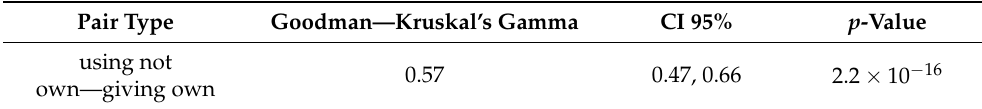
Table 4. Goodman–Kruskal’s gamma statistic for subjective associations between social behaviors related to lending own smartphone to other persons and using someone else’s